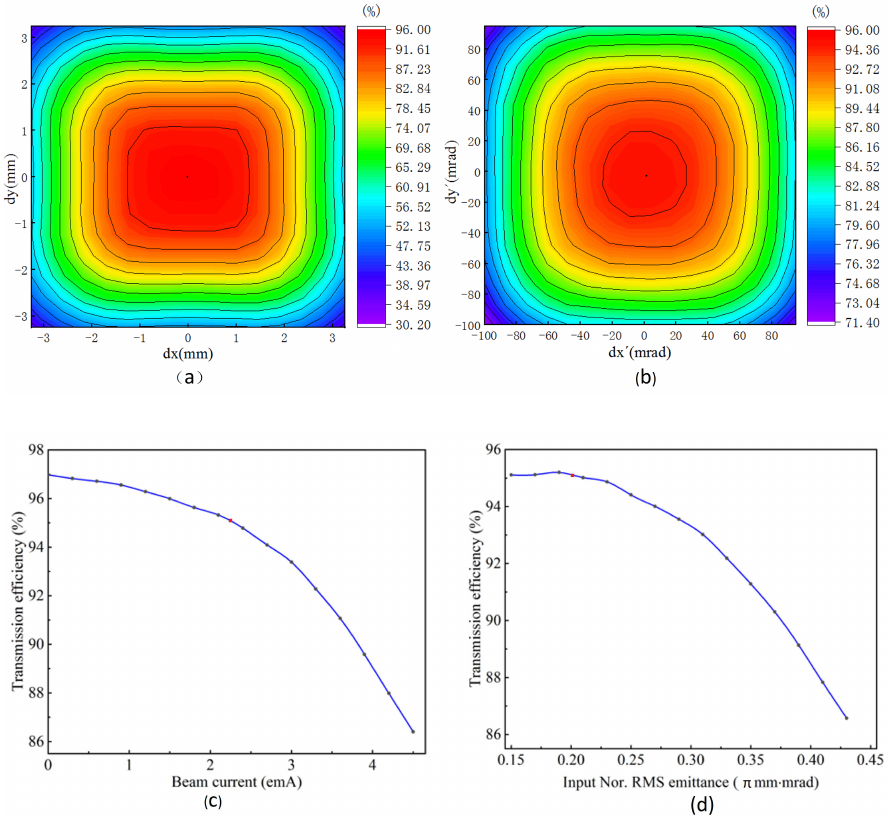
Figure 4. Transmission efficiency of the RFQ versus ( a ) Beam offset, ( b ) Beam tilt, ( c ) Beam current ( 132 Sn 22 + ), and ( d ) Input Nor. RMS emittance.